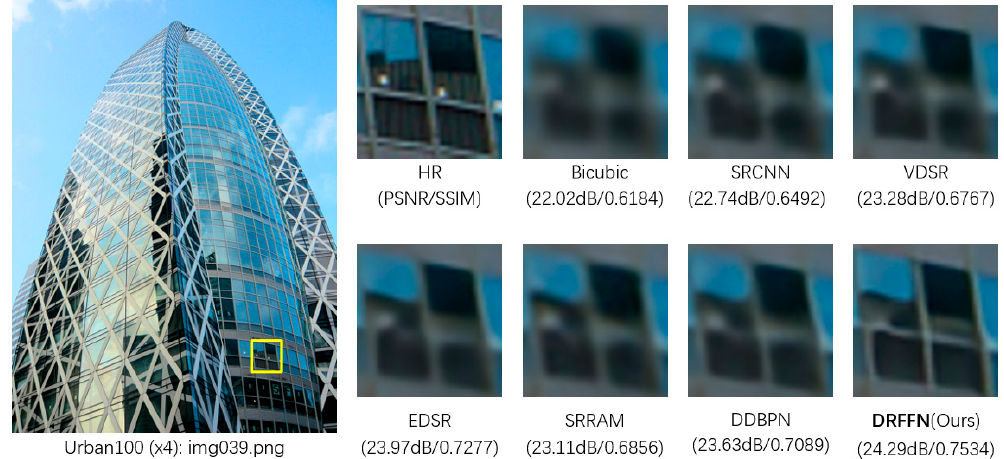
Figure 10. Qualitative comparison of DRFFN with other methods (×4).